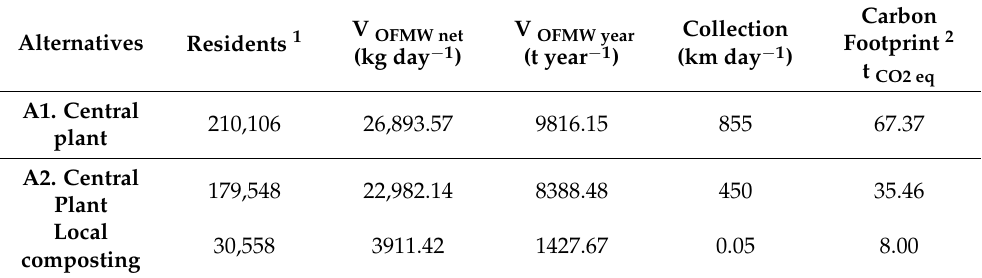
Table 6. Comparison of alternatives of OFMW transport from an environmental point of